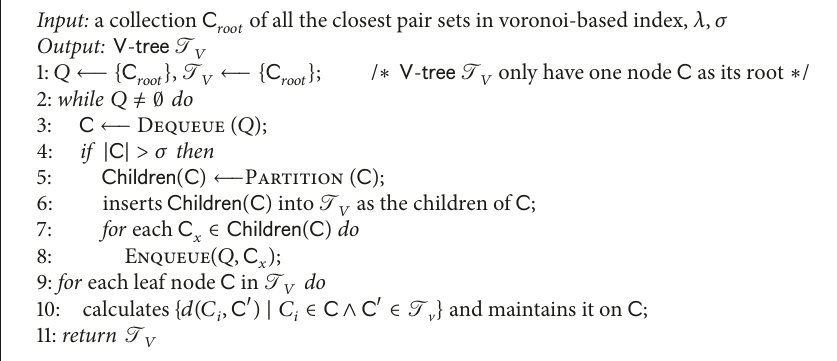
Algorithm 3: Construct-Vtree ( C 𝑟𝑜𝑜𝑡 ,𝜆, 𝜎)